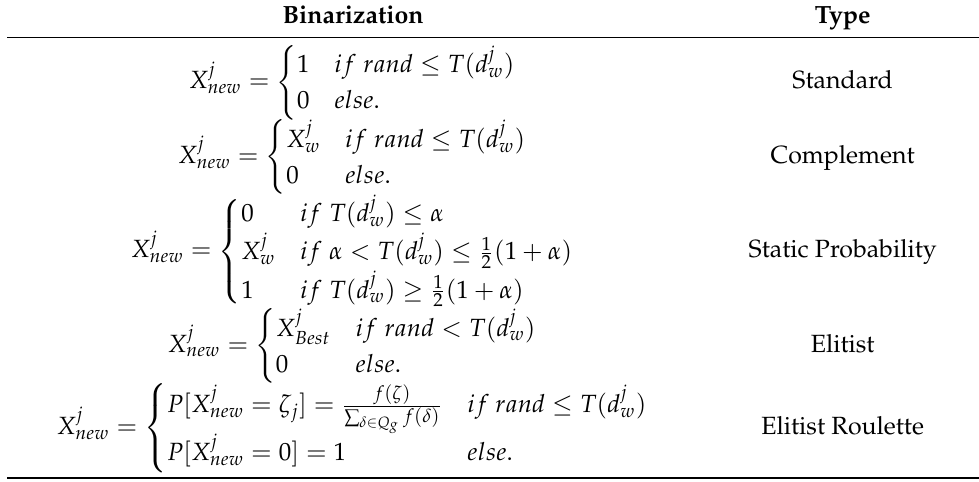
Table 2. Techniques of binarization